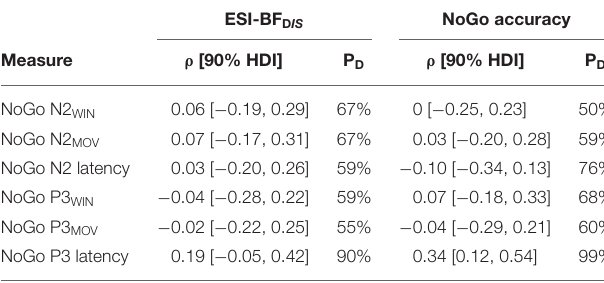
TABLE 3 | Posterior estimates of